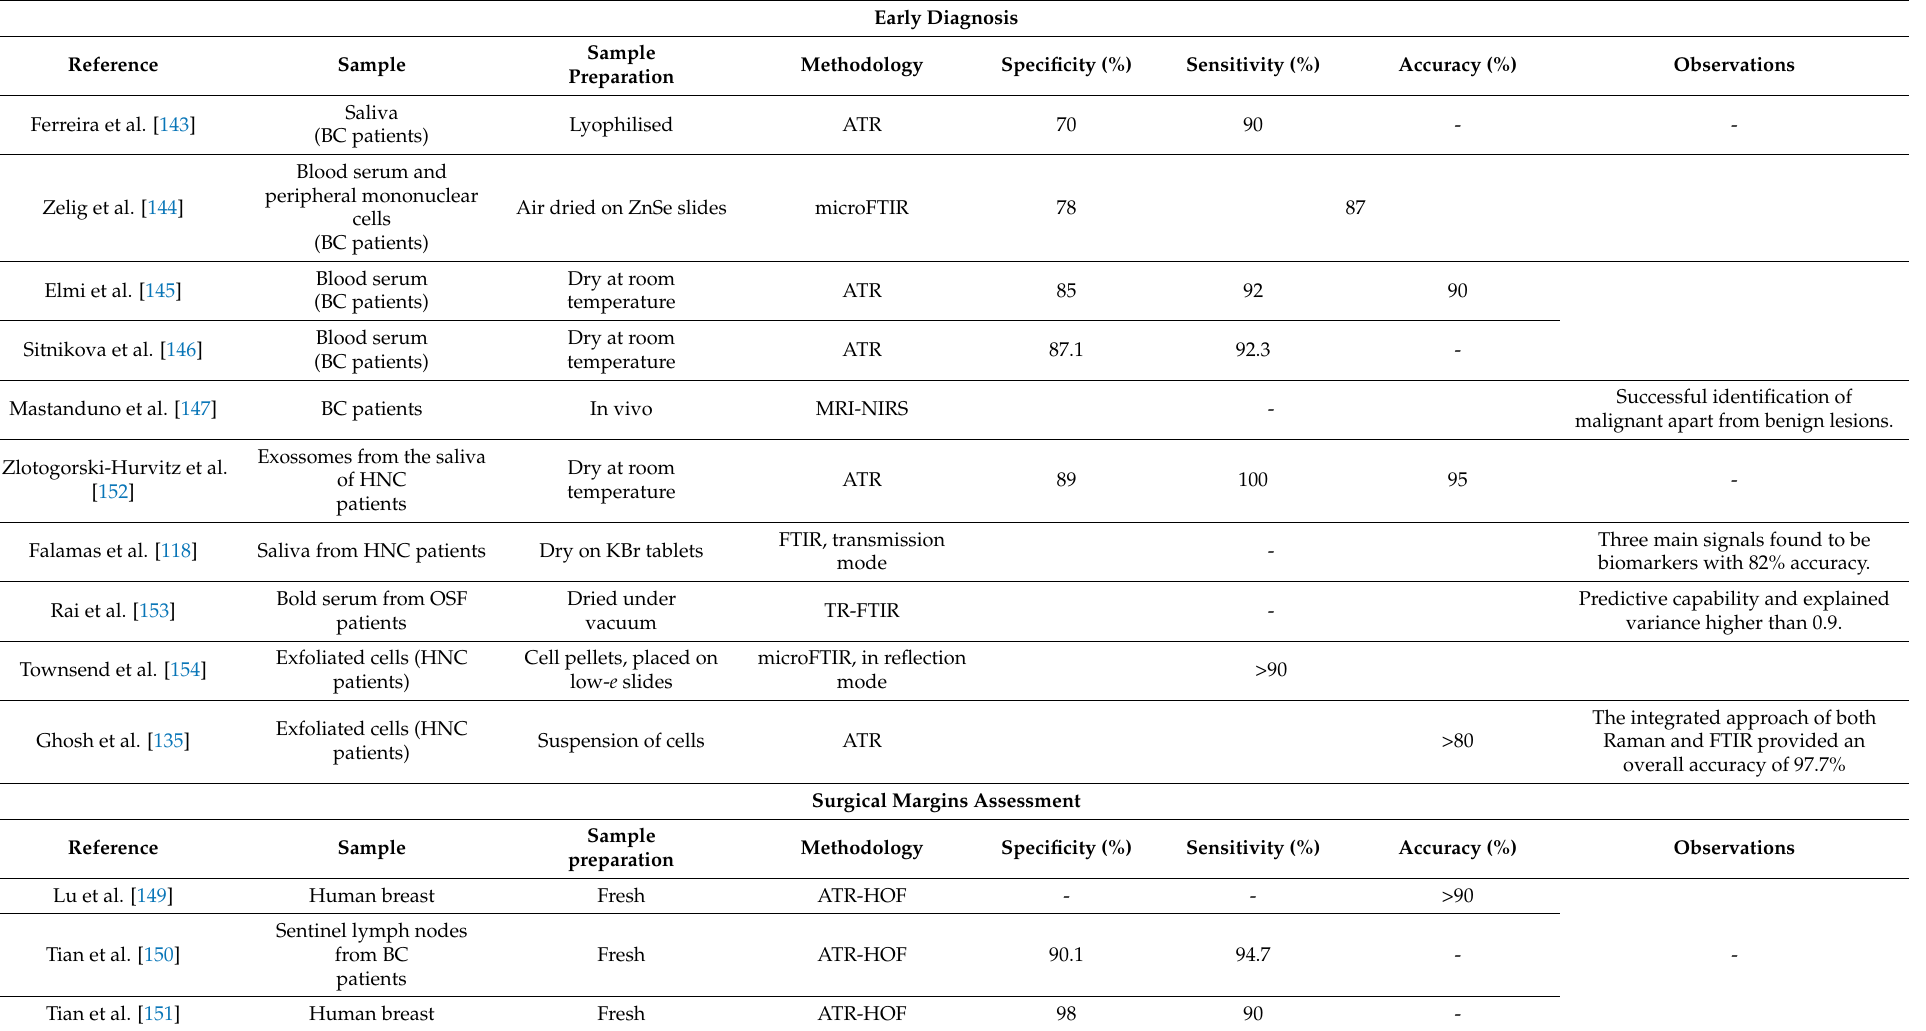
Table 2. Summary of the research studies included in this review article, performed with FTIR spectroscopy, according to the type of sample, sample preparation, methodology and specifications